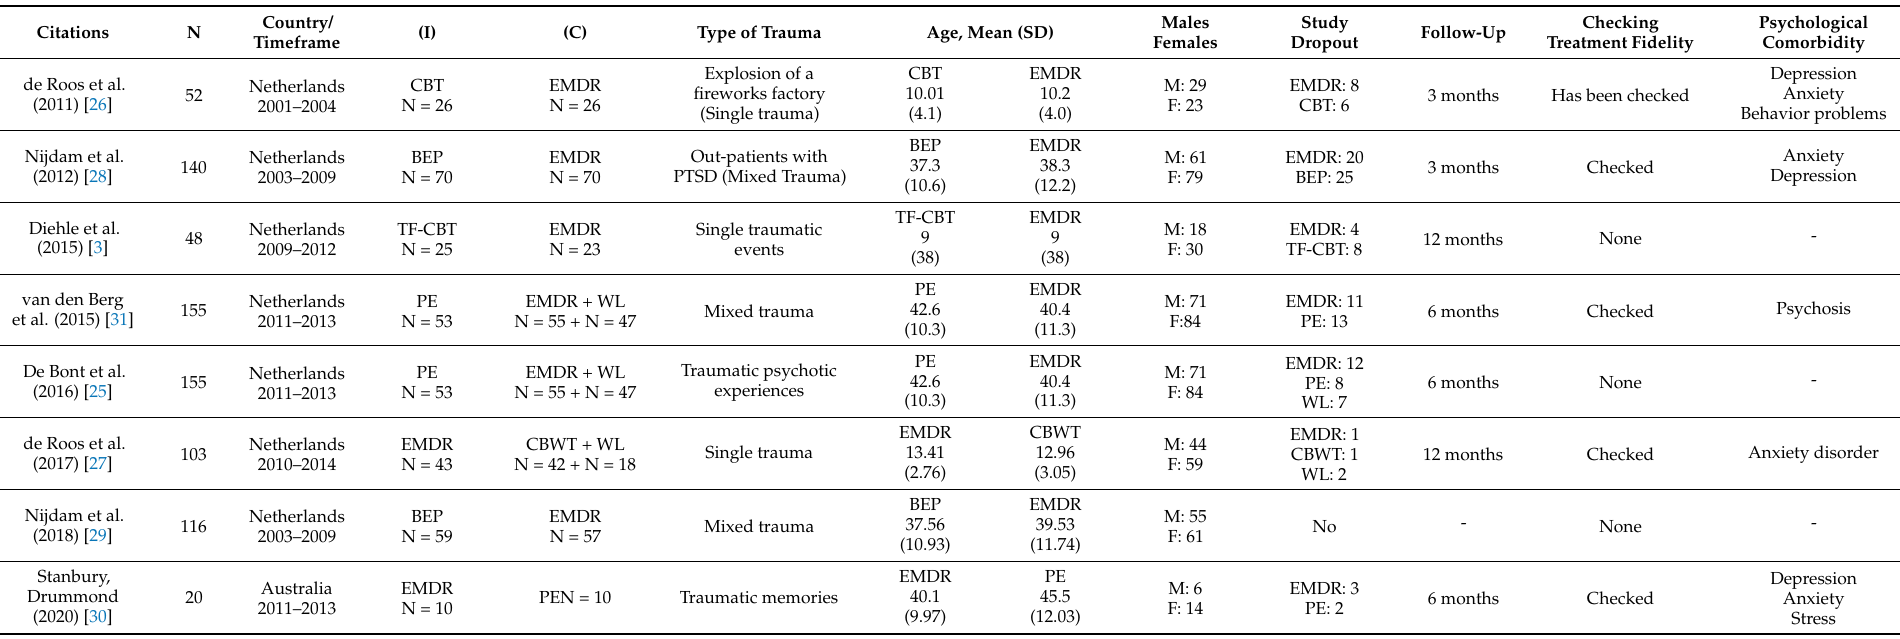
Table 1. Characteristics of the included RCT